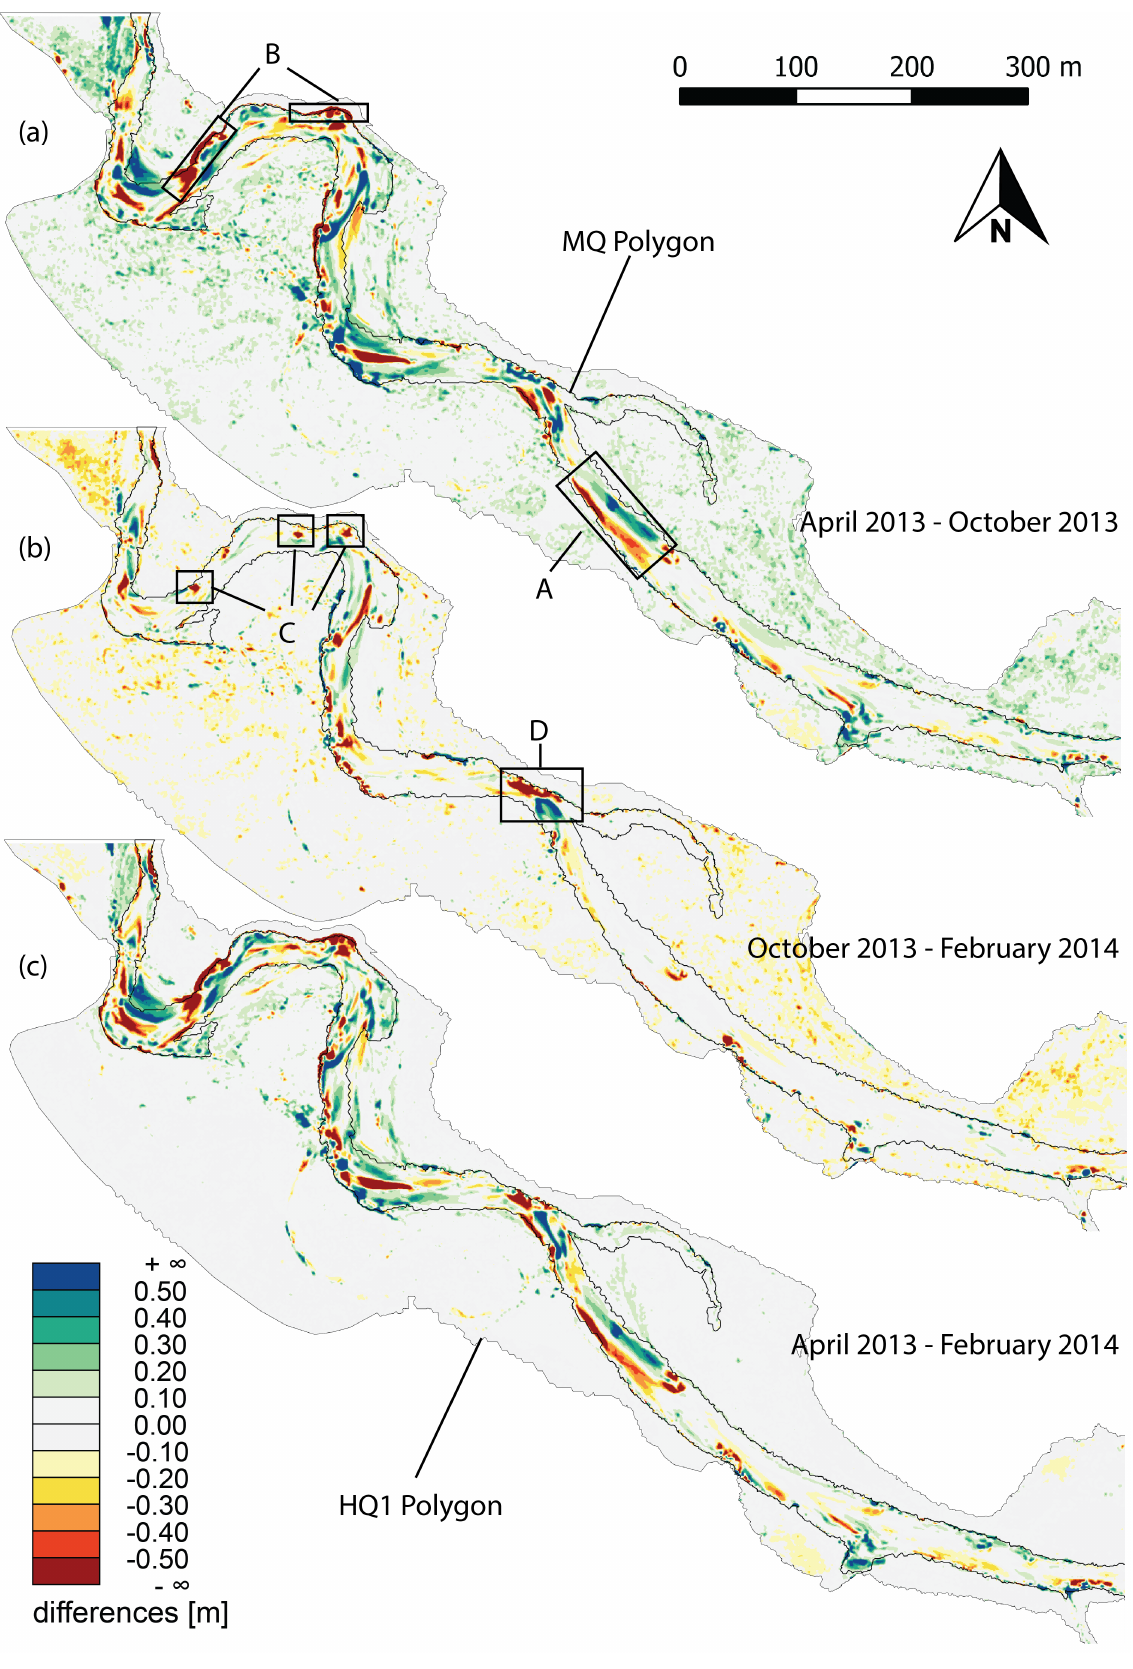
Figure 10. Color-coded visualizations of the raw (unmasked) DoD documenting the changes caused by the annual flood event in June 2013; ( a ) Period April 2013–October 2013; ( b ) Period October 2013–February 2014; ( c ) Period April 2013–February